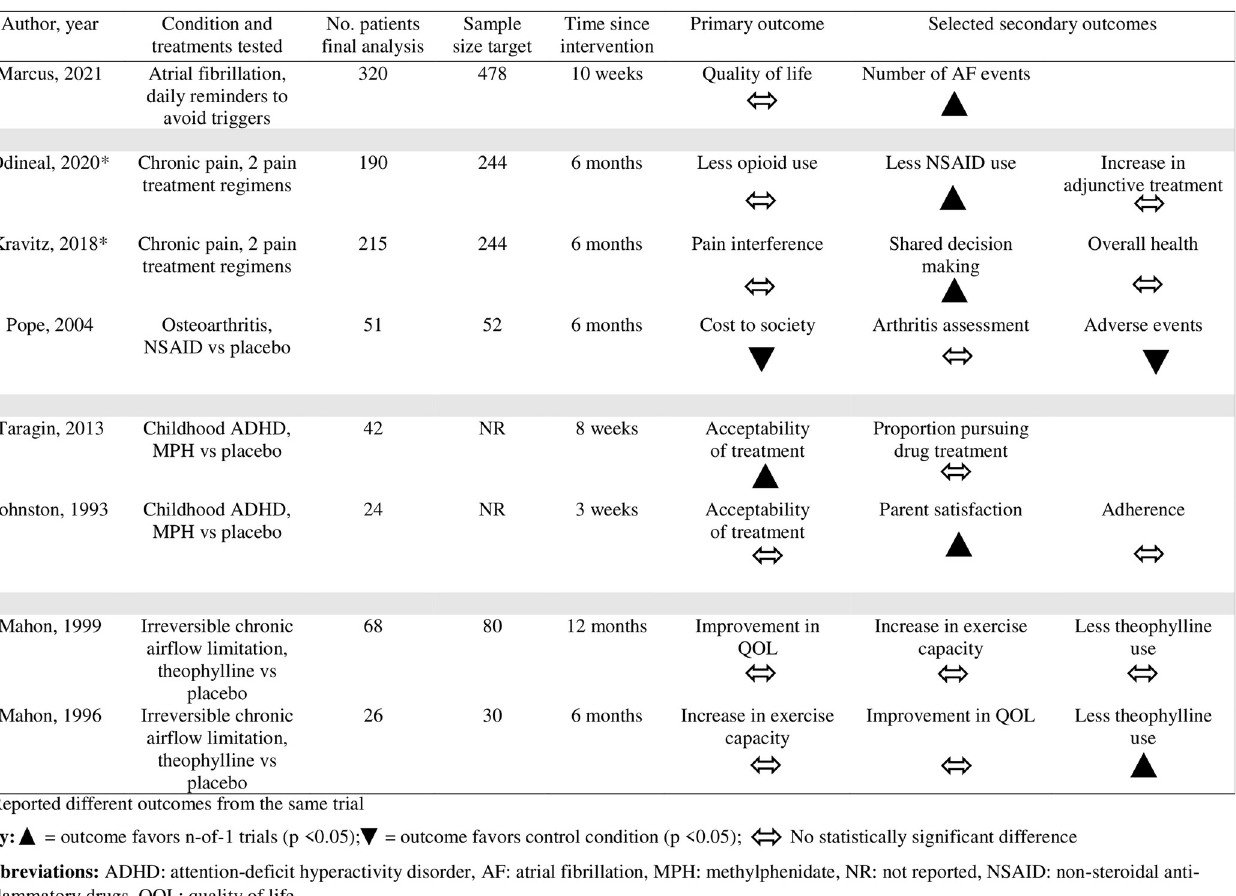
Fig 2. Summary of primary outcome and selected secondary outcomes from studies with results published.